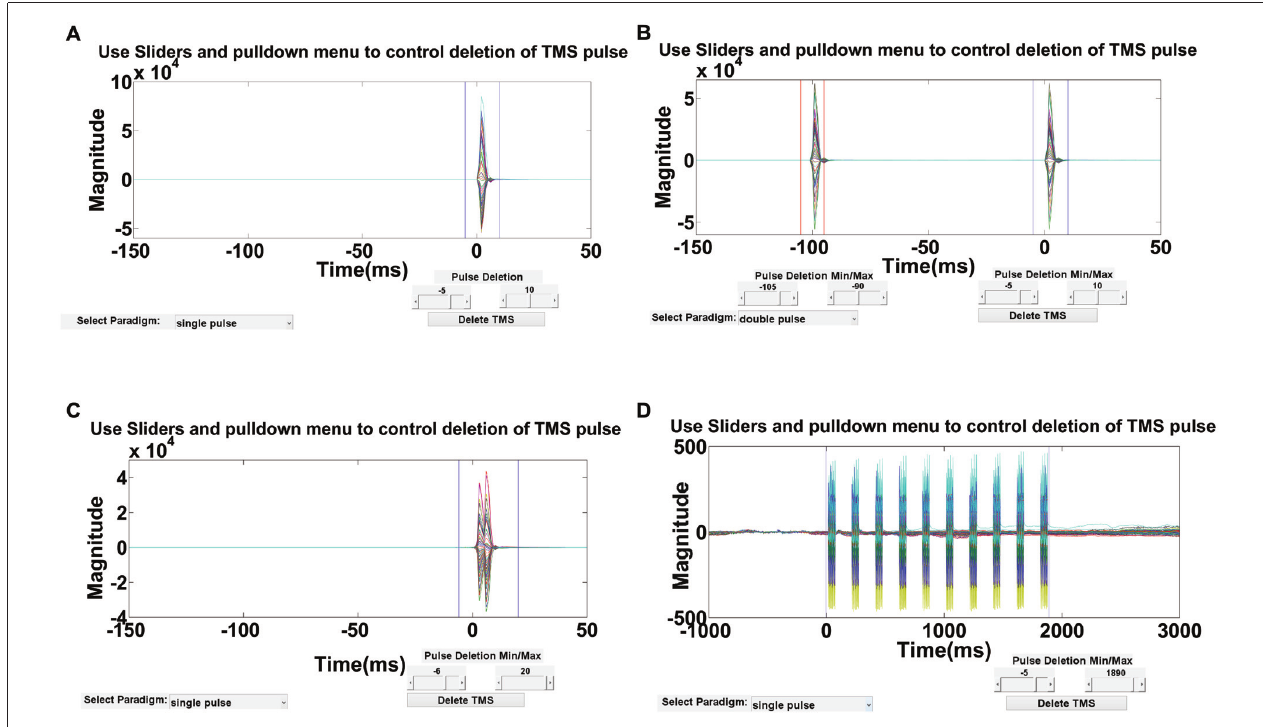
FIGURE 4 | Step 2 GUI for removing the large-amplitude TMS pulse artifact. Figures display the average butterfly plot of all EEG data epochs plotted over a time range of − 150 ms to 50 ms relative to time of the test pulse in (A–C) , and − 1000 ms to 3000 ms relative to the first repetitive TMS (rTMS) pulse in (D) . X -axes represent time in milliseconds and y -axes represent the amplitude of the EEG signal in µ V. Sliders indicate the time range for data removal. The user can specify the time range for deletion using the provided sliders for four types of TMS-EEG paradigms: (A) single-pulse, (B) long-interval (100 ms) paired-pulse, (C) short-interval (5 ms) paired-pulse, and (D) rTMS (specifically intermittent theta burst